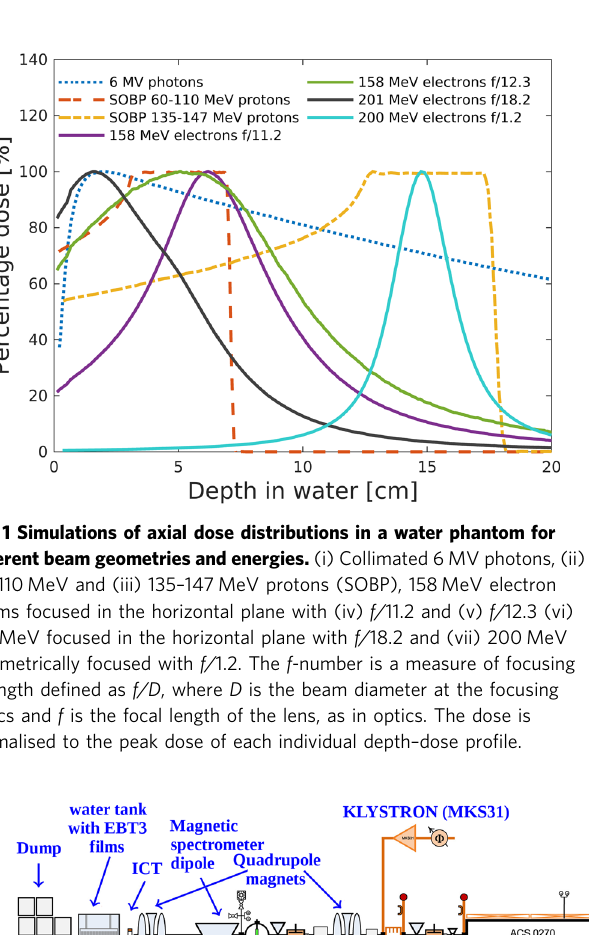
Fig. 2 The CLEAR accelerator, beamline and schematic of the experimental setup. The electron beam (travelling from right to left) is produced by a radio-frequency (RF) gun and accelerated up to 220 MeV by three 4.5 m long S-band accelerating structures driven by 2 modulators/klystrons (MKS11 and MKS15). A third klystron (MKS31) can power a transverse de fl ector. The fi rst structure (Buncher) can also be used to longitudinally compress the electron bunches. Beam diagnostics include a beam position monitor (BPM) and integrating current transformer (ICTs) to measure the charge at different stages. The electron beam energy is measured using a dipole electromagnet that also directs the beam to the VESPER test bench. Two triplets of quadrupole magnets focus the beam inside the water phantom, which is placed at the end of the beamline and is shown in detail in Fig.